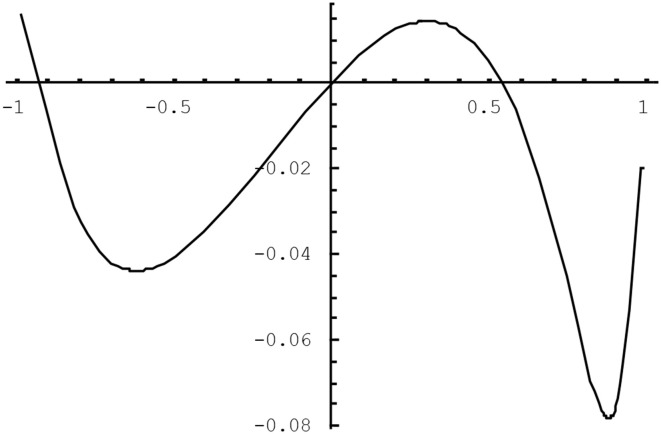
ρ*ab − ρab as a function of the tetrachoric correlation for ha = −0.8 and hb = 0.3.